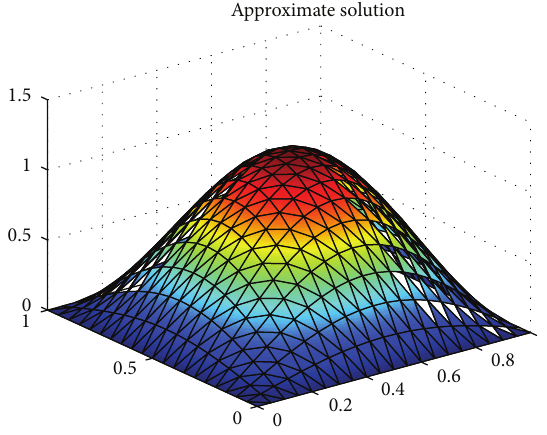
Figure 1: The Exact solution.